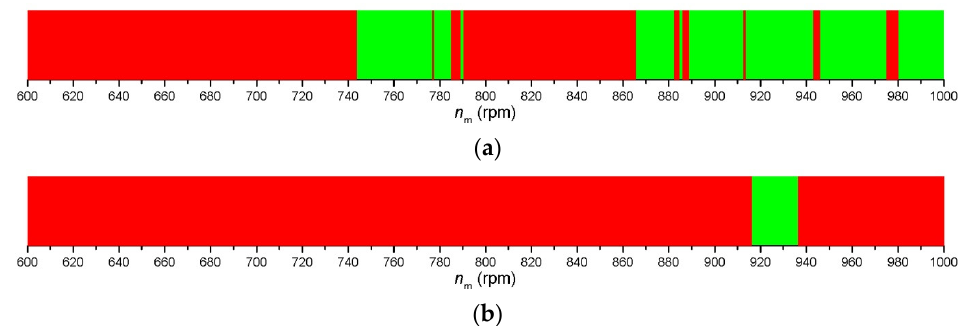
Figure 21. The FREM domains of the excessive (red) vs. permissible (green) total vertical ( a ) and lateral ( b ) accelerations.